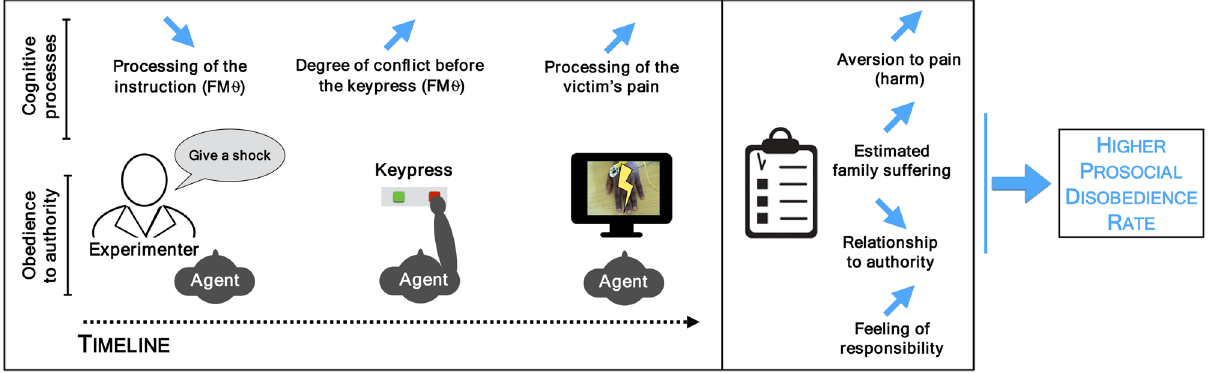
Figure 4. Schematic representation of the different factors associated with a higher prosocial disobedience rate. The blue line indicates the directionality of the